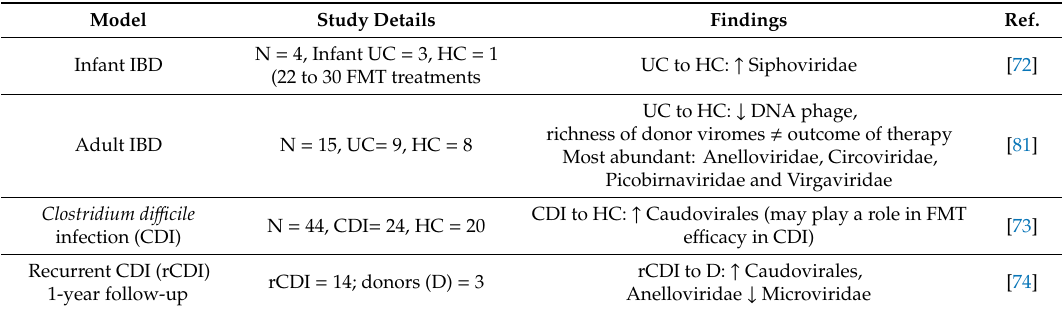
Summary of studies and their findings involving in viromes from fecal microbial transplantations